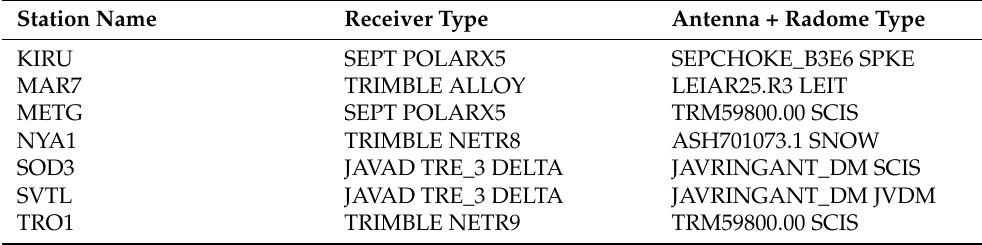
Table 2. The GNSS receivers and the antenna + radome types of the high latitude stations.